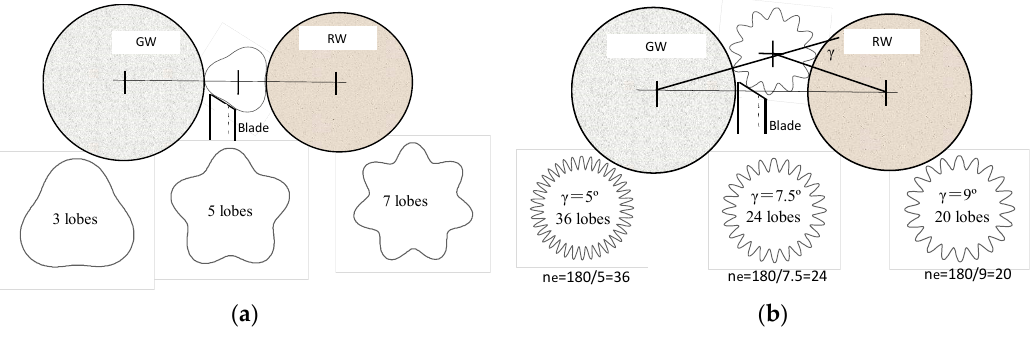
Figure 9. Effect of center-height angle on rounding mechanism. ( a ) Odd lobe appearance at lower γ ; ( b ) Even lobe appearance at a specific γ .